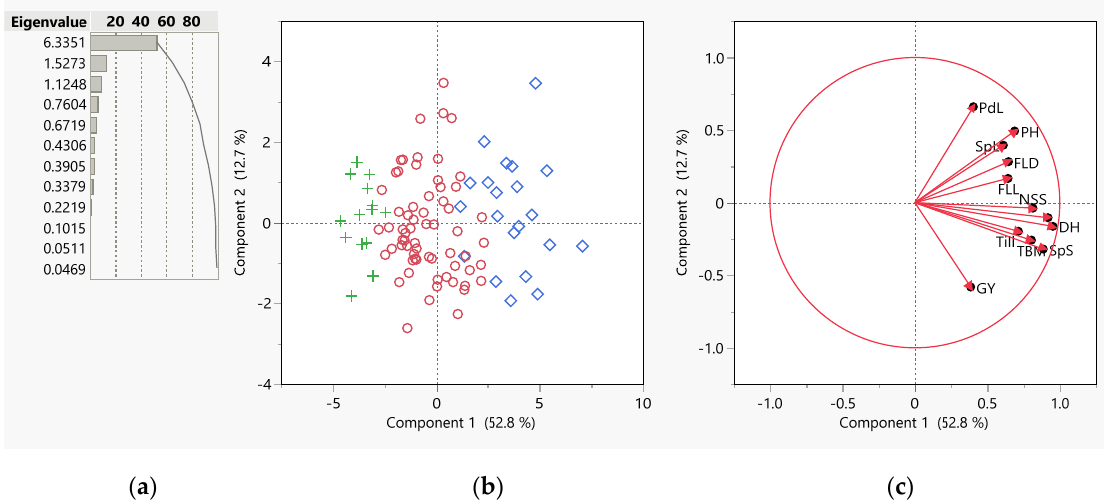
Figure 3. Summary plots having ( a ) Eigenvalue Pareto plot depicting eigenvalues and a bar chart of variation percentage accounted for by each PC; ( b ) sore plot between PC-1 and PC-2 displaying the distribution of 101 wheat genotypes in three groups; ( c ) loading plot with correlations between variables and the selected two PCs.